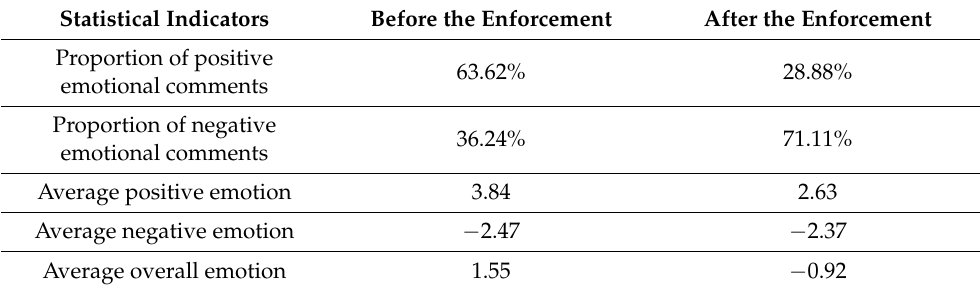
Table 3. Emotional